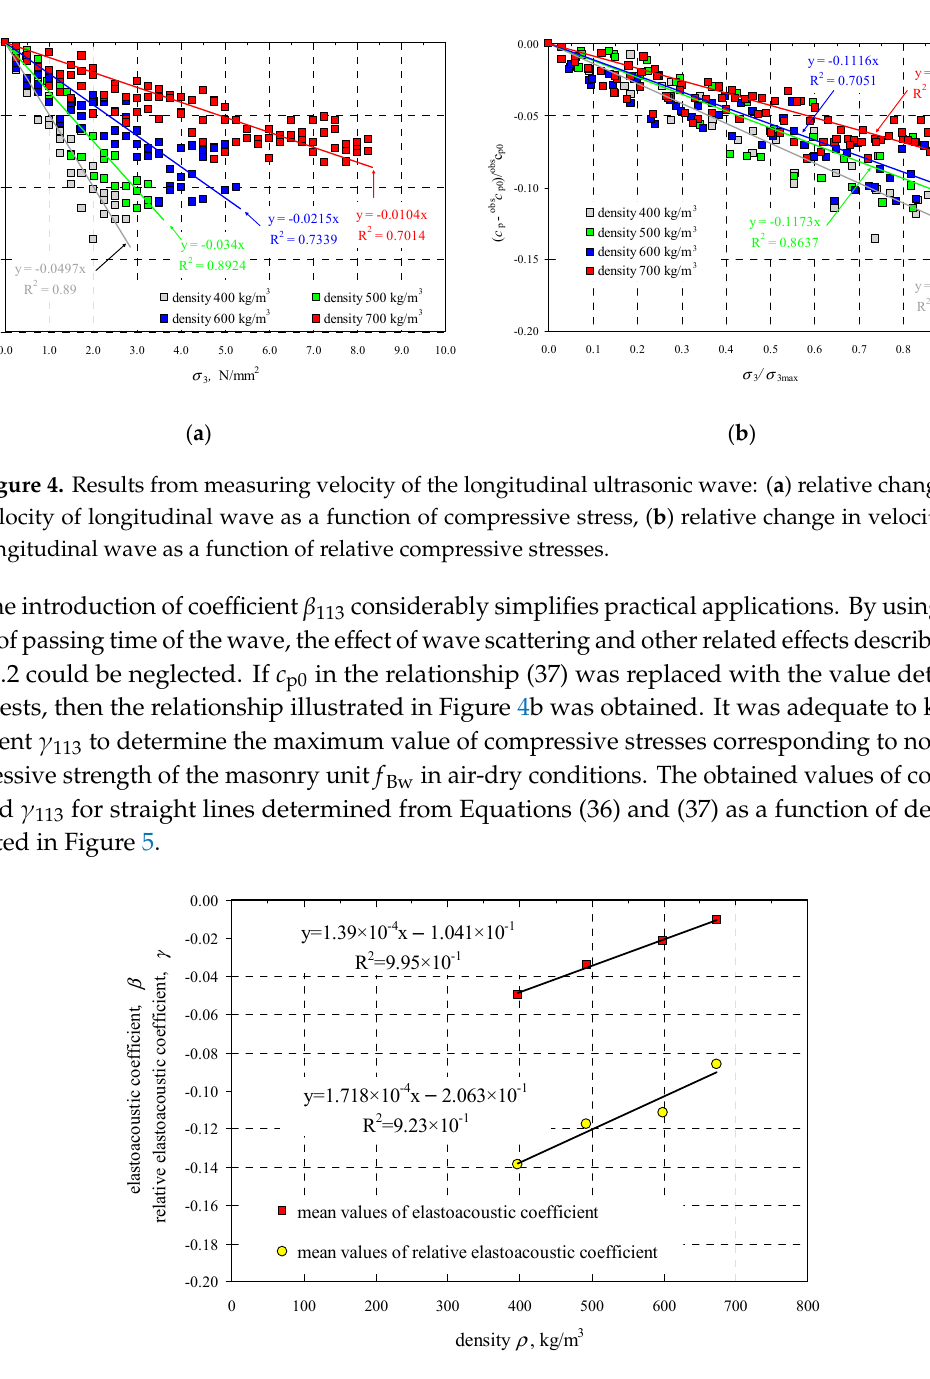
Figure 5. Values of coe ffi cients β 113 and γ 113 as a function of AAC density.